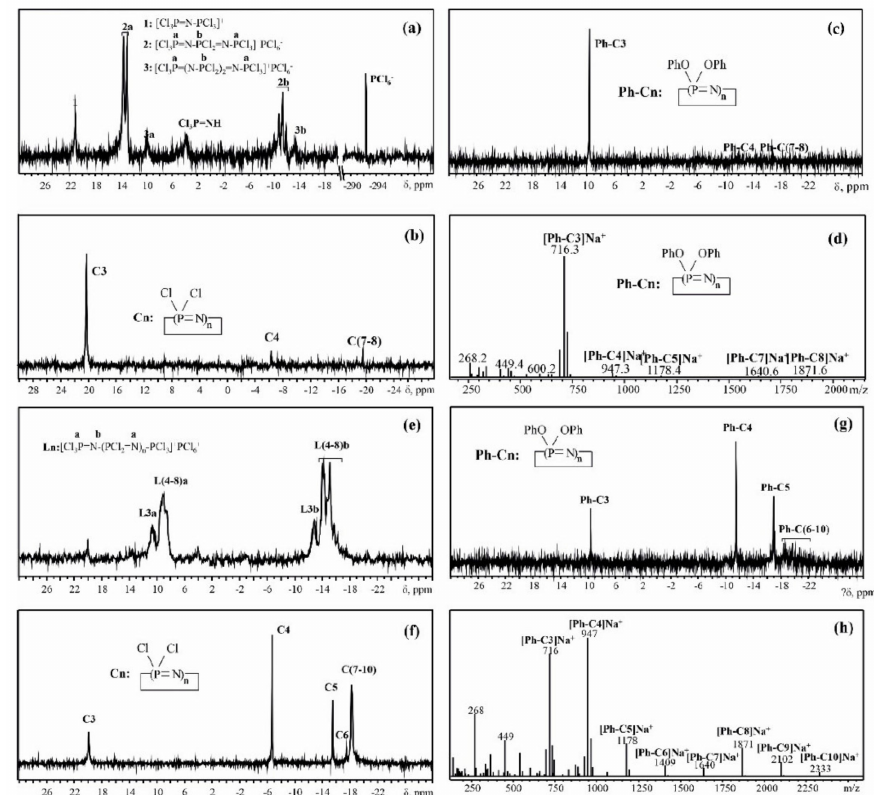
Figure 6. 31 P NMR spectra of linear oligophosphazene: [Cl(PCl 2 =N) 2 PCl 3 ] + [PCl 6 ] − ( a ) and [Cl(PCl 2 =N) 4 PCl 3 ] + [PCl] 6 − ( e ); product of their cyclization ( b , f respectively), phenoxylated deriva- tives of cyclization products ( c , g respectively) and MALDI-TOF spectra of phenoxylated products ( d , h